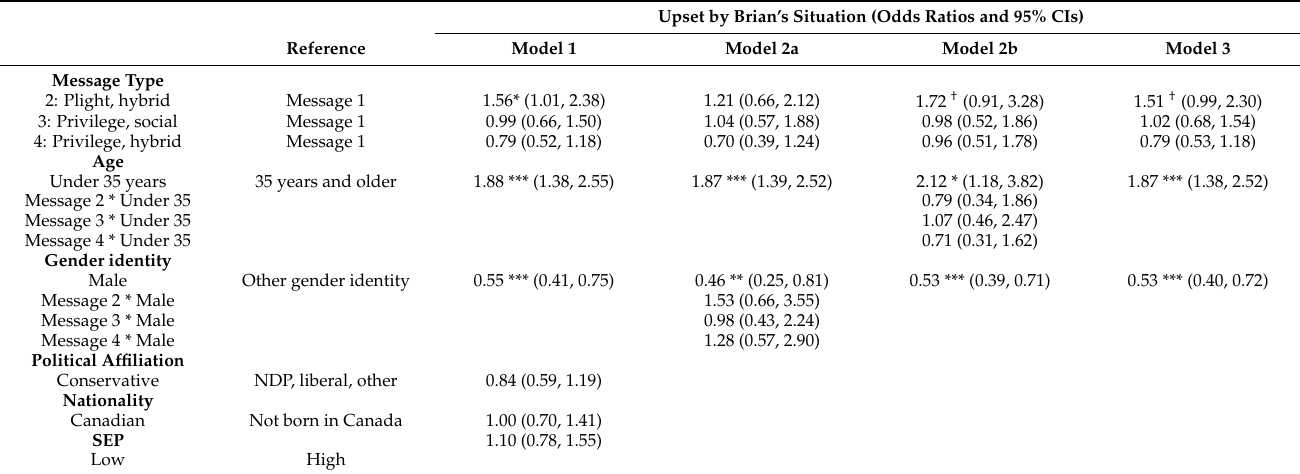
Table 4. Logistic Regression Models, predictors of upset by Brian’s situation. Upset by Brian’s Situation (Odds Ratios and 95% CIs) Reference Model 1 Model 2a Model 2b Model